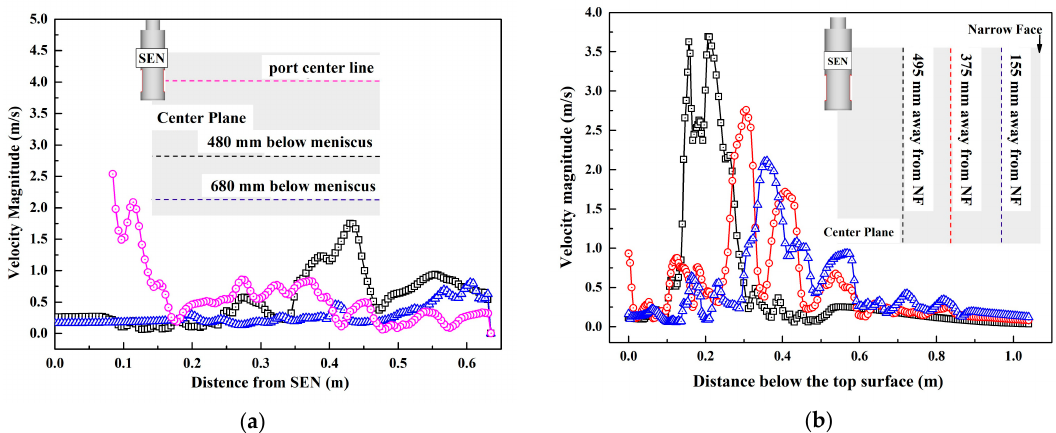
Figure 12. Velocity distribution of different lines at several locations: ( a ) horizontal variations; ( b ) vertical variations.